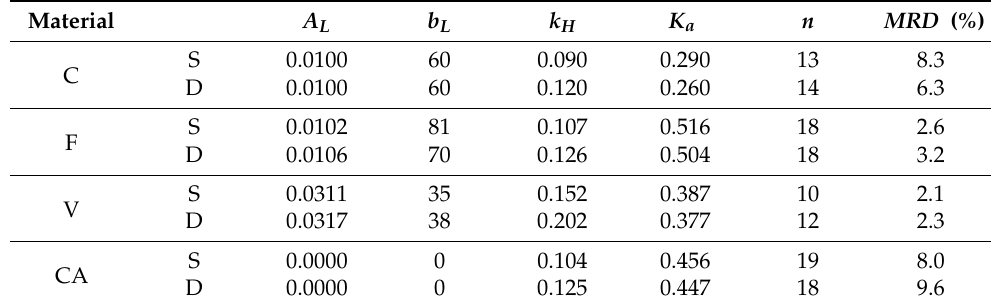
Table 3. Crystallinity index of the